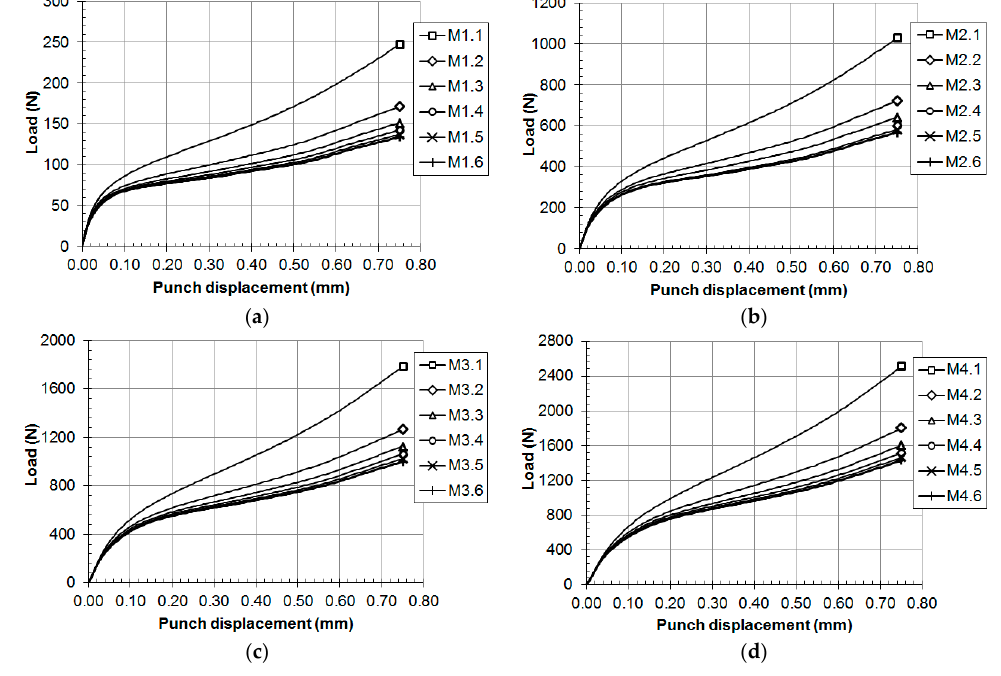
Figure 8. SPT curves for the hypothetical materials: ( a ) M1.x, ( b ) M2.x, ( c ) M3.x and ( d ) M4.x.